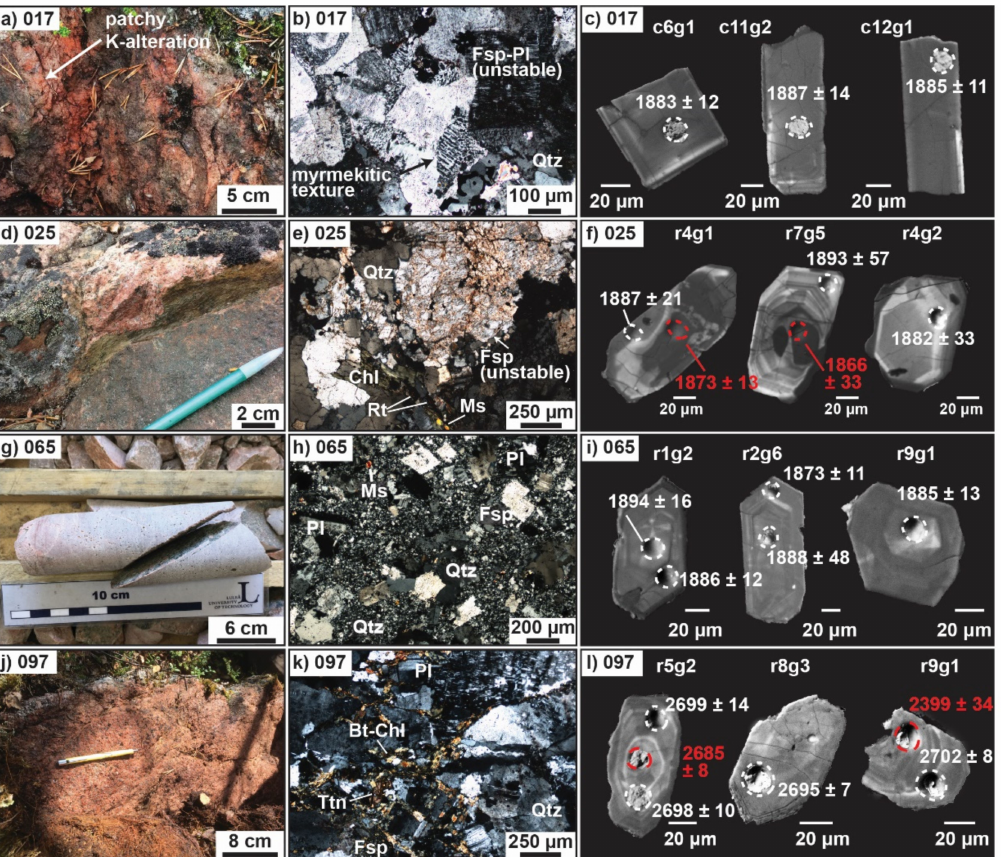
Figure 5. Sample images from the Saarijärvi area. ( a ) Outcrop at the sampling locality 017 showing patchy K-feldspar alteration with quartz. ( b ) Micrograph of 017 showing unstable feldspars and plagioclase with myrmekitic textures along grain boundaries, in XPL. ( c ) Cathodoluminescence images of typical zircon grains for sample 017. ( d ) Sample 025, medium-coarse-grained syenite in outcrop with a cross-cutting epidote-altered fracture plane. ( e ) Micrograph of sample 025 with brittle fractures filled with chlorite, rutile, and muscovite, in XPL. ( f ) Cathodoluminescence images of typical zircon grains for sample 025. ( g ) Drill core sample 065 of fine-grained granite intersection. ( h ) Micrograph of sample 065 showing a porphyritic texture with recrystallized quartz–plagioclase matrix, in XPL. ( i ) Cathodoluminescence images of typical zircon grains for sample 065. ( j ) Sample 097, Archean granite in outcrop. ( k ) Micrograph of sample 097 showing brittle fractures filled with biotite–chlorite, titanite, and feldspar, in XPL; ( l ) Cathodoluminescence images of typical zircon grains for sample 097. In ( c , f , i , l ), dashed white circles highlight each concordant SIMS spot analysis while red circles and text are discordant. Ages reported are 207 Pb/ 206 Pb ± 2 σ . Abbreviations: